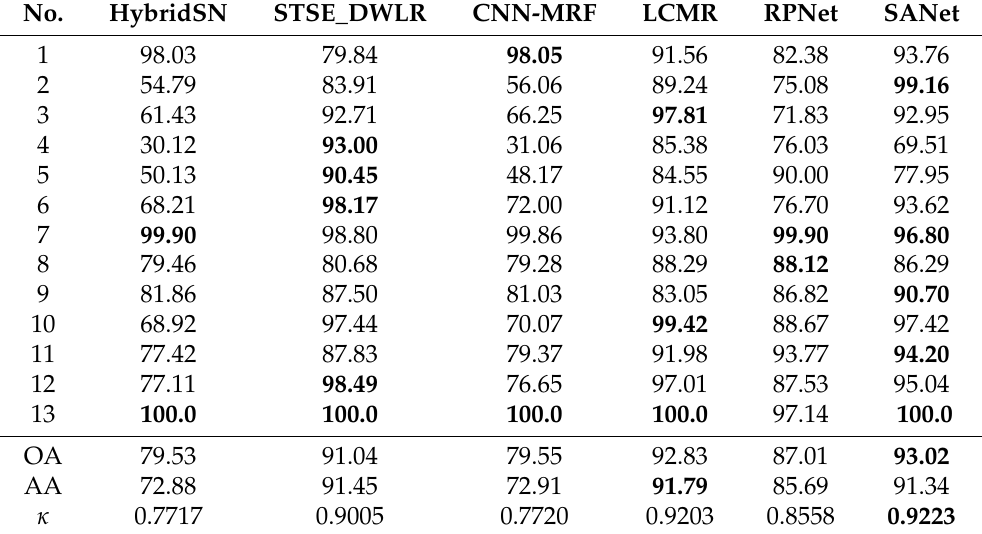
Table 5. Classification accuracies of HybridSN, STSE_DWLR, CNN-MRF, LCMR, RPNet, and SANet on the KSC data set. The best results are highlighted in bold